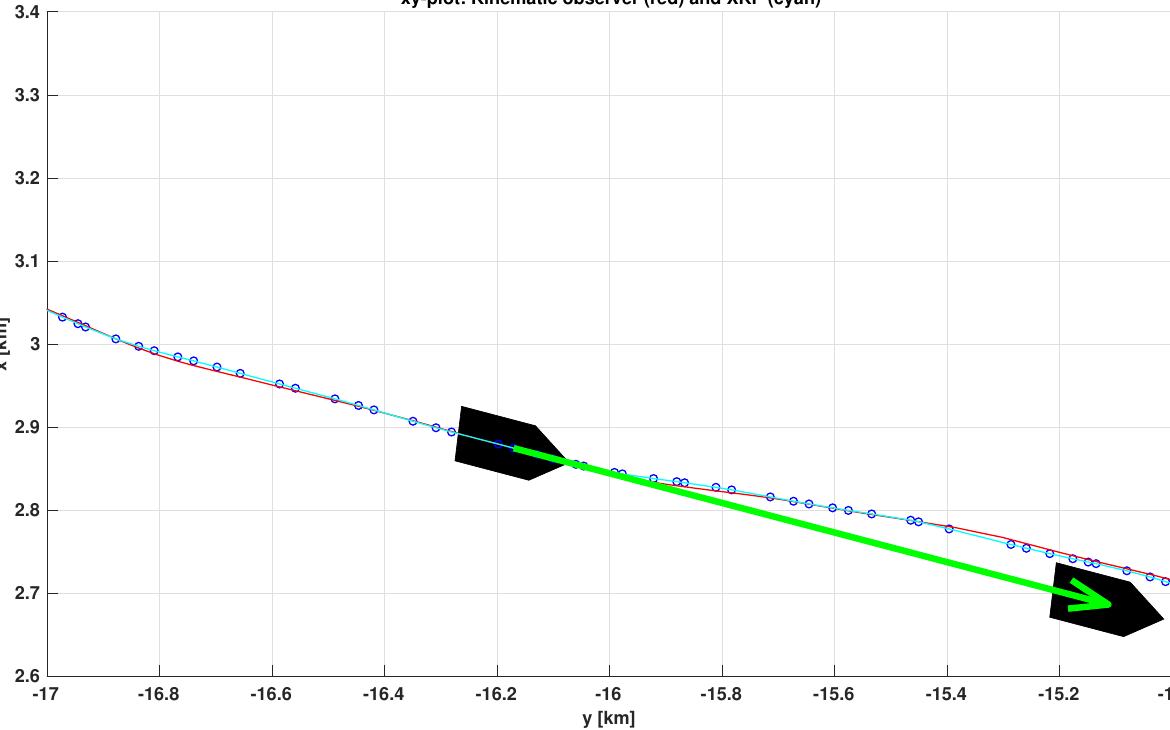
Figure 9: The 60 seconds predicted motion of MS LADEJARL when on route to Trondheim harbor. The red and cyan lines are the kinematic observer and XKF, respectively